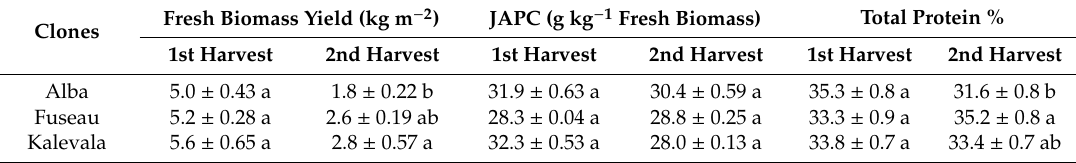
Table 1. Aerial fresh biomass, dry mass, and total protein content of Jerusalem artichoke leaf protein concentrate (JAPC) isolated from green biomass of di ff erent